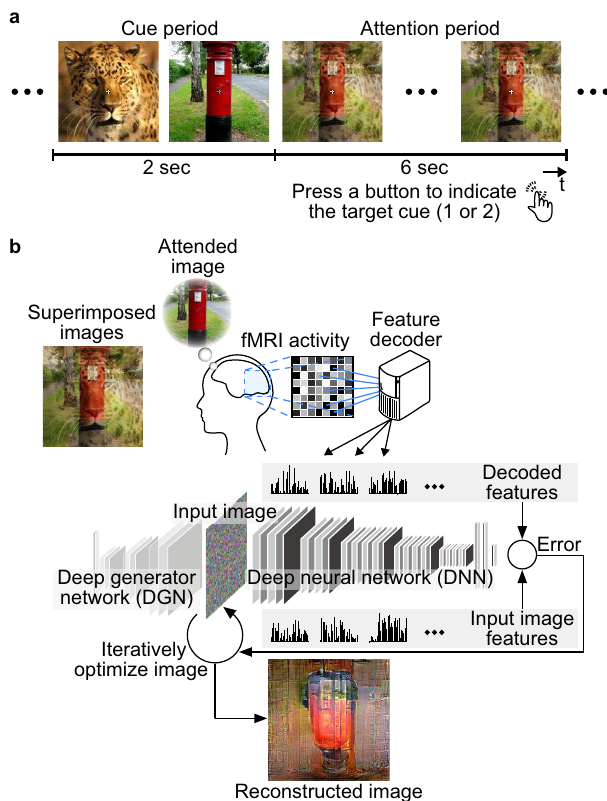
Fig. 1 Overview of image reconstruction from brain activity during attention. a Experimental design of attention trials. In each trial, two cue images and a superposition of the preceding two cue images ( fl ashed at 2 Hz) were sequentially presented to subjects. During an attention period, subjects were asked to attend to one of two superimposed images indicated by green fi xation color during cue periods while ignoring the other. Subjects pressed a button to indicate which of the fi rst or second images were attended to for con fi rmation. b Reconstruction procedure. Given a set of decoded features for all DNN layers as a target of optimization, the method 3 optimizes pixel values of an input image so that the features computed from the input image become closer to the target features. A deep generator network (DGN) 45 was introduced to produce natural-looking images, in which optimization was performed at the input space of the DGN (see Methods: “ Visual image reconstruction analysis ”